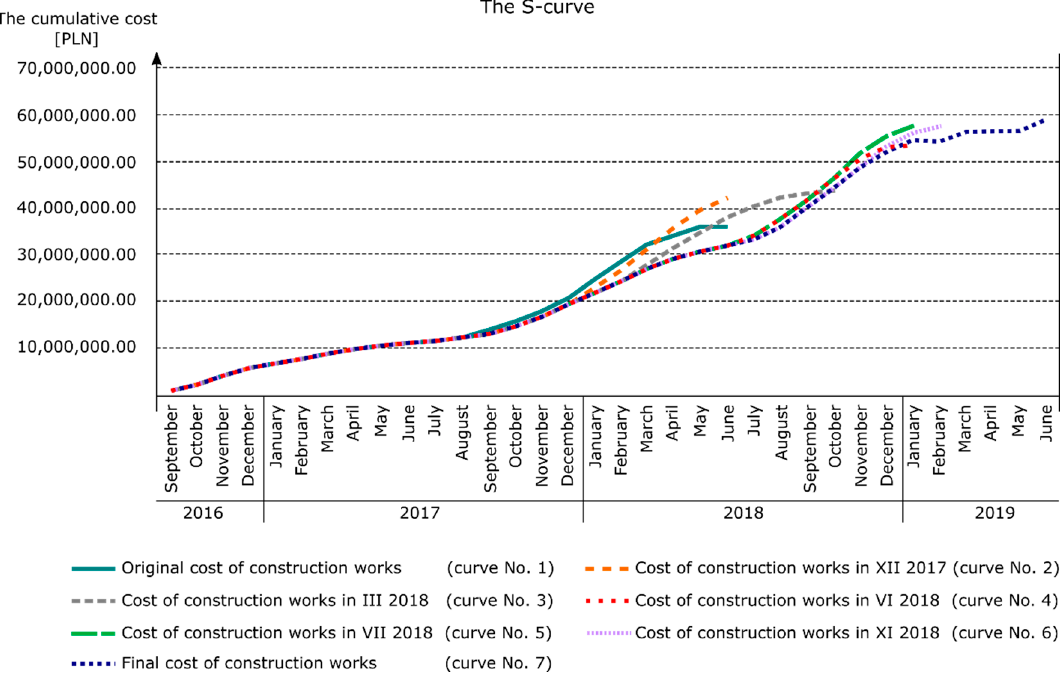
Figure 2. Planned and actual cumulative costs of the completed hotel facility (own elaboration). Table 1 summarizes the collected data concerning the completed construction